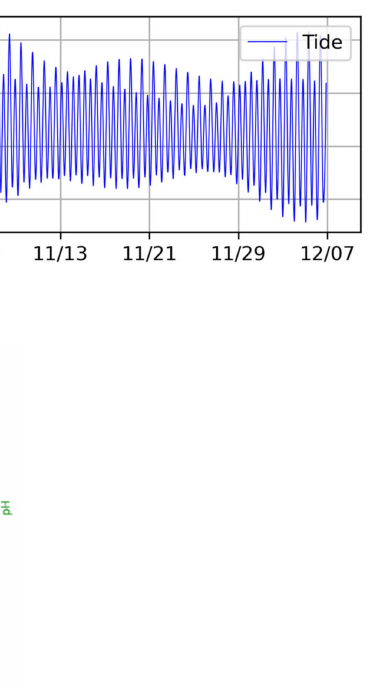
Figure 3. Temperature, salinity, and pH. Table 1. Major ion concentrations in seawater during the